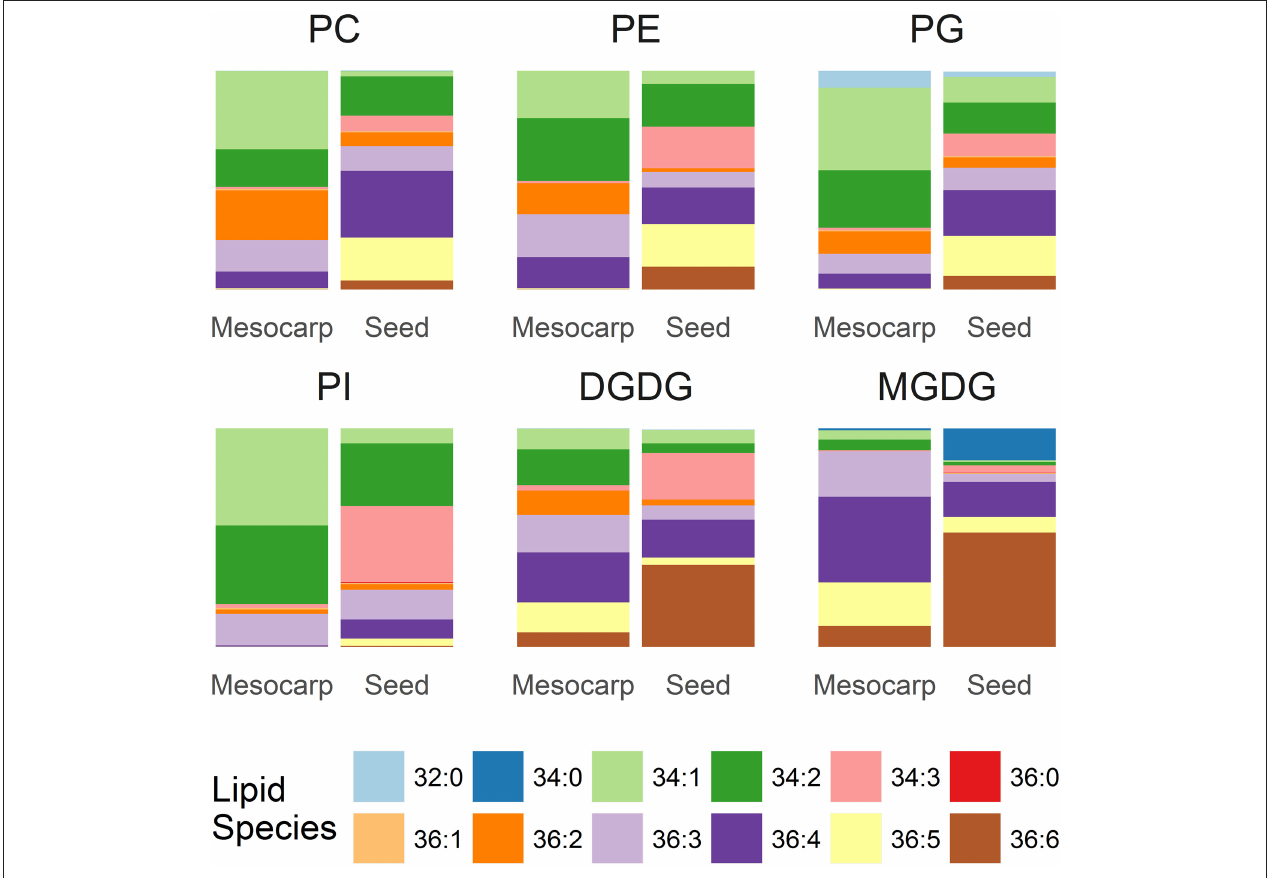
FIGURE 5 | Composition of phospholipids and galactolipids in Triadica sebifera LD isolated from stage III immature mesocarp and seed kernel.